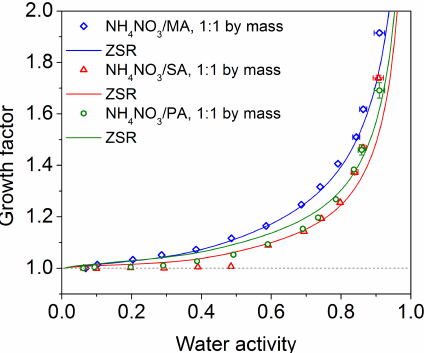
Figure 3. Hygroscopic growth factors of 100nm internally mixed particles composed of NH 4 NO 3 / malonic acid (MA), NH 4 NO 3 / succinic acid (SA) and NH 4 NO 3 / phthalic acid (PA) with equal mass ratios as a function of water activity. The blue, red and green solid lines indicate the hygroscopic growth predicted from the ZSR method. The error bars representing the standard de- viation of multiple measurements are generally not obvious com- pared to the size of the